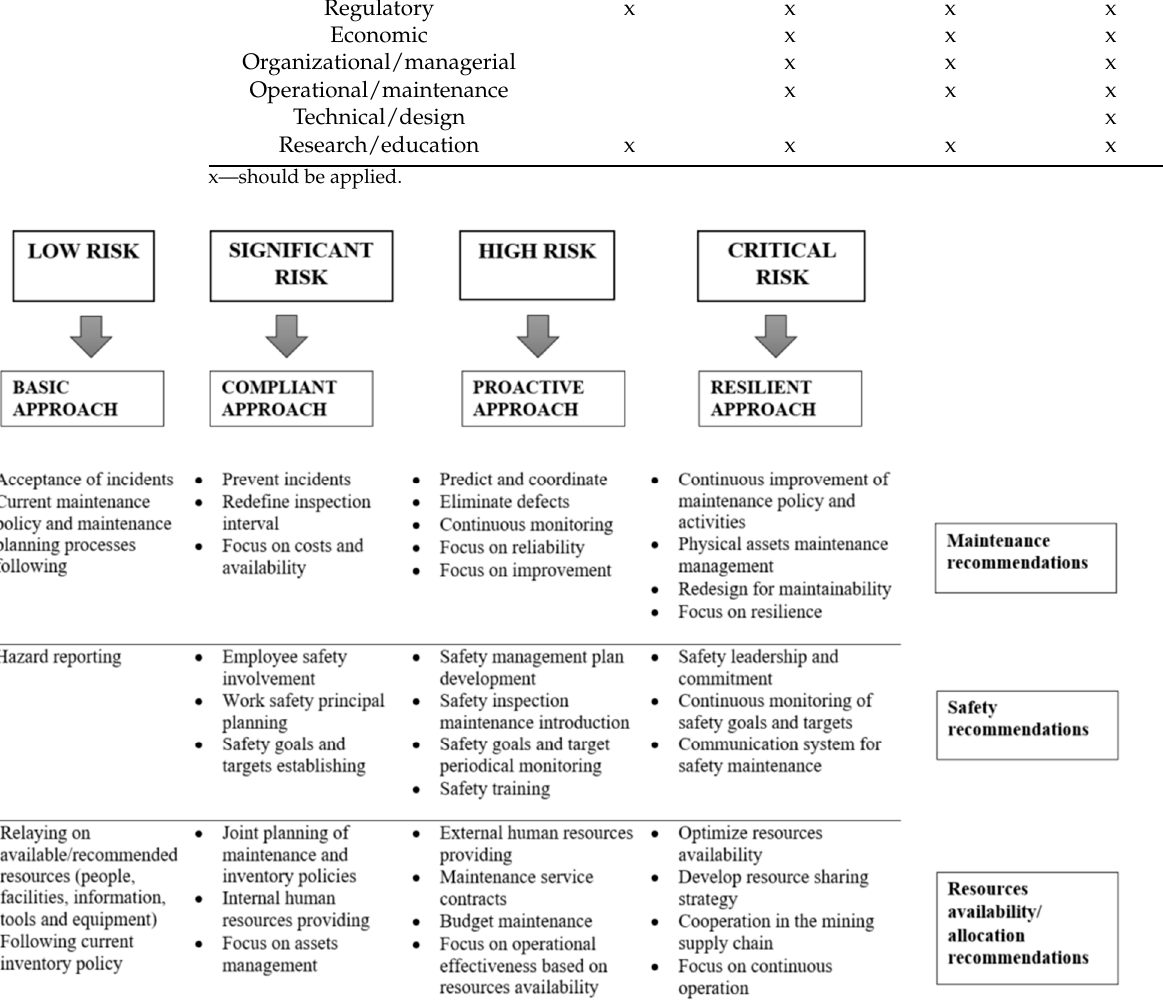
Figure 9. Proposed recommendations, based on obtained risk level—possible directions of company’s related tasks in the three main improvement areas.